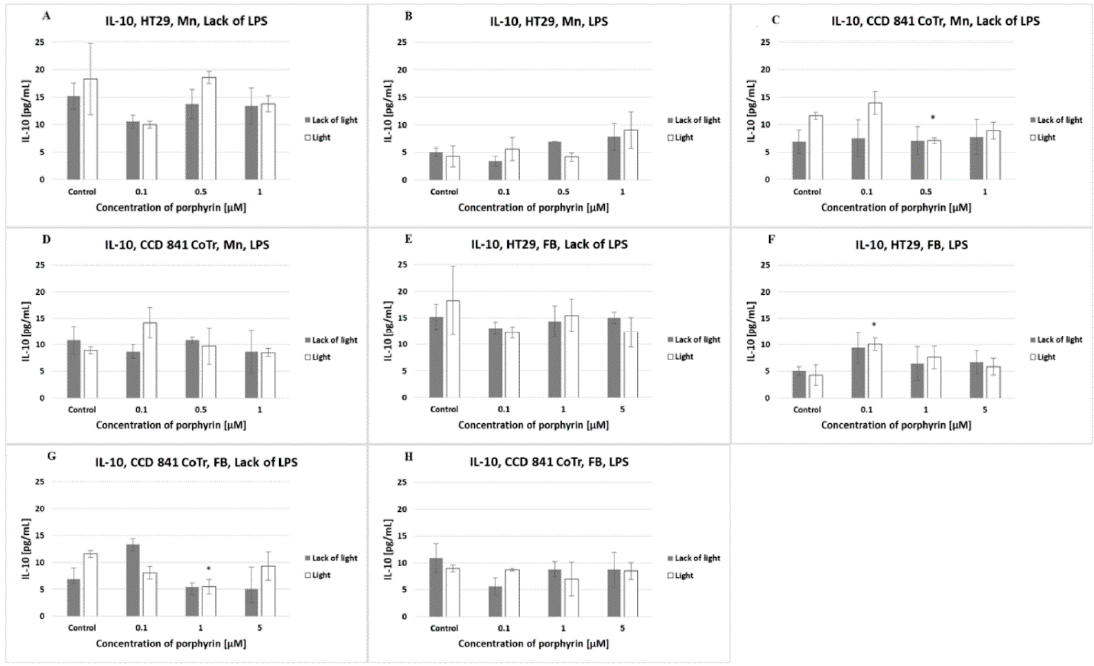
Figure 8. IL-10 secretion at the HT29 cell line (A, B, E, F) and culture of CCD 841 CoTr cells (C, D, G, H) over 24 h of incubation with manganese (Mn) (A-D) and free-base (FB) (E-H) porphyrins. ELISA test. Cells treated with porphyrin compared with a non-treated control culture. Cells treated with porphyrin compared with cells treated with porphyrin after pre-incubation with LPS. Columns and bars show the mean ± standard deviation ( n = 3). * - Statistical significance was analyzed at p <